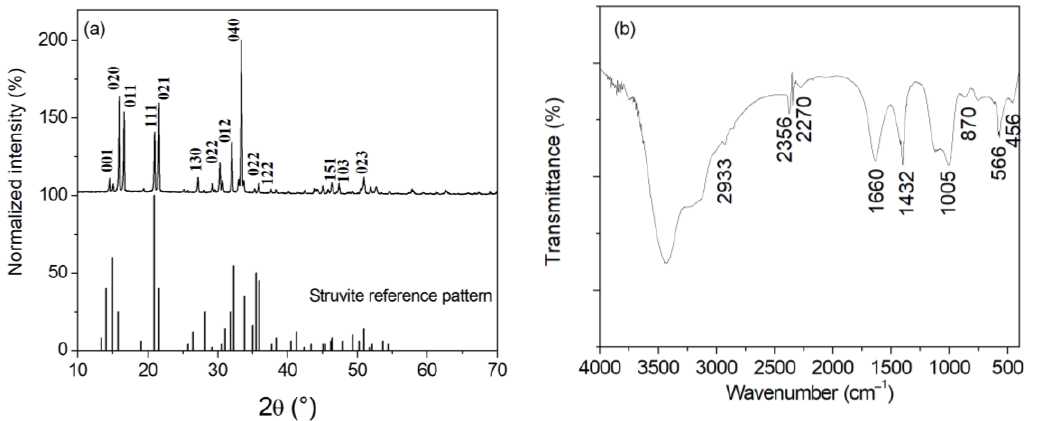
Figure 1. Typical examples of the ( a ) XRD pattern and ( b ) FTIR spectrum of the obtained precipi- tates.